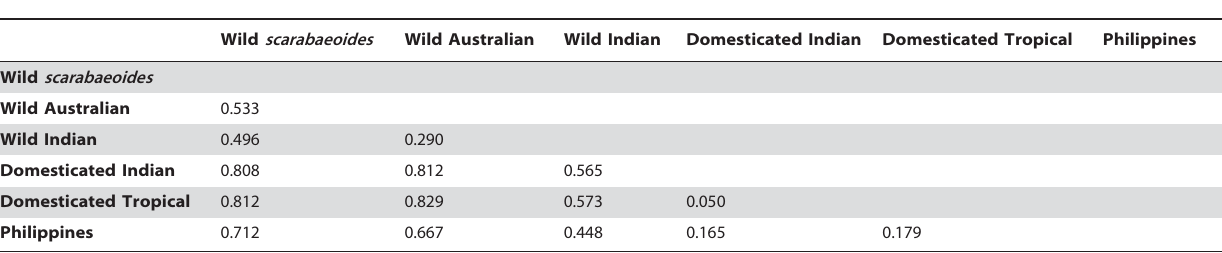
Table 3. Pairwise estimates of FST among wild and domesticated